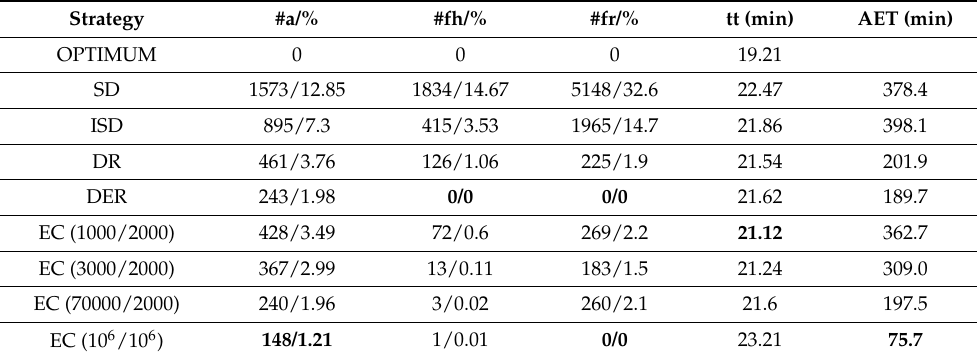
Table 3. Experimental results for Madrid. Bold numbers indicate the best obtained result for each metric.